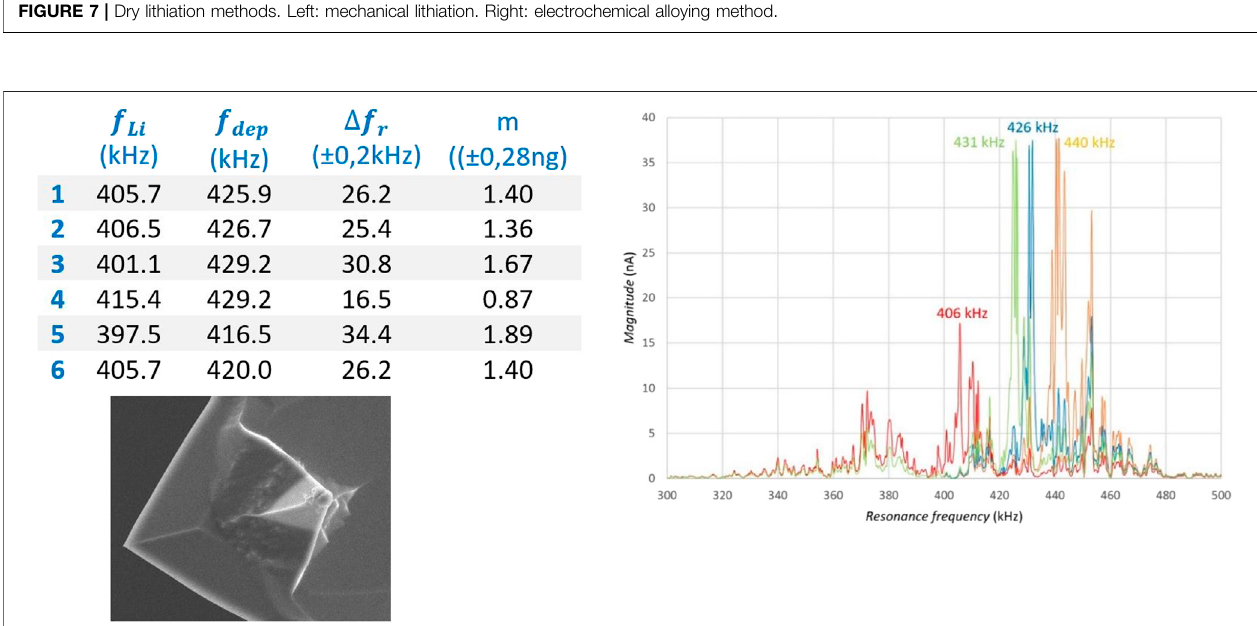
FIGURE8| Resonanceshiftasresultoflithiationbyusingthemechanicalmethodfollowedbyelectrochemicalde-lithiation:orange (cid:1) Pristine;Blue,afterelectrolyte dipping; Red, after mechanical plating on the tip; Green, after deposition back to the substrate.